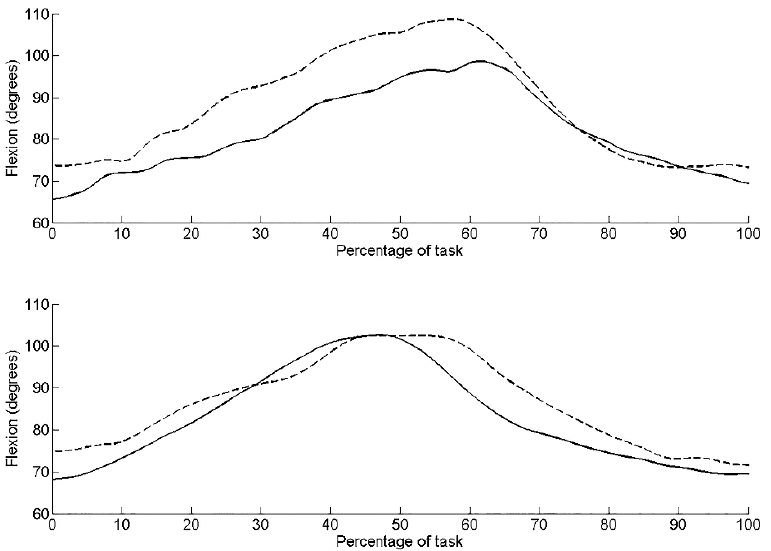
Figure 5. External rotation during the seated hip flexion task for the left side (upper graph) and right side (lower graph). Dashed line represents pre-intervention, solid line represents post-intervention.